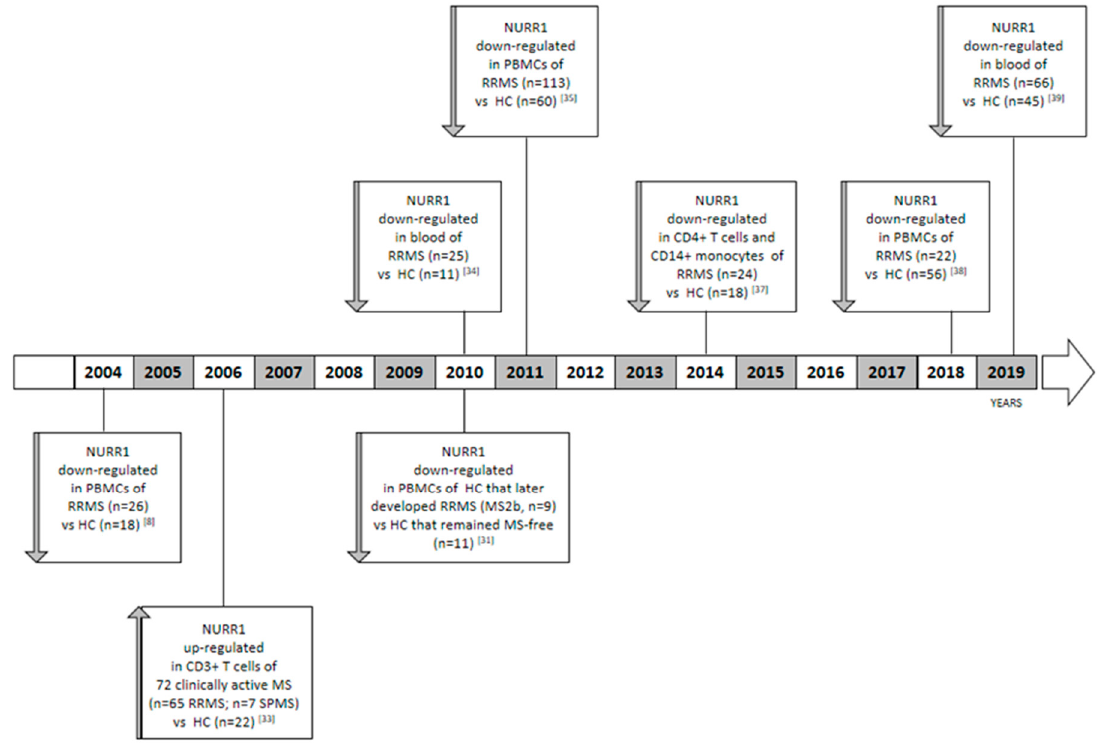
Figure 1. Timeline showing the published data related to the gene expression level of NURR1 in multiple sclerosis (MS).